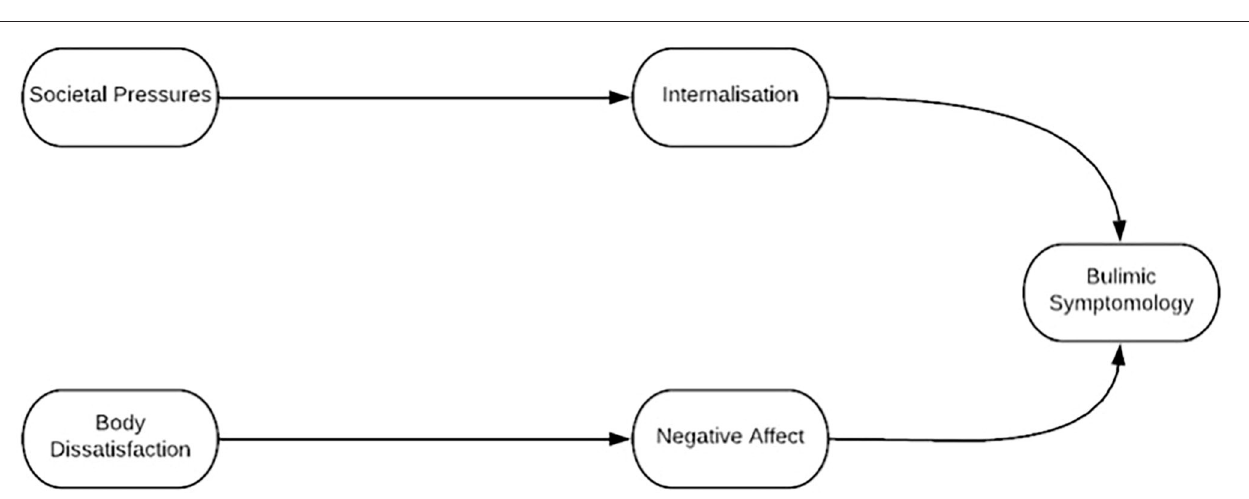
FIGURE 2 | T1 model: Revised model by Stoyel et al. (2020). This model has been corrected from the first published version which coined the social pressures rather than societal pressures in the top, right